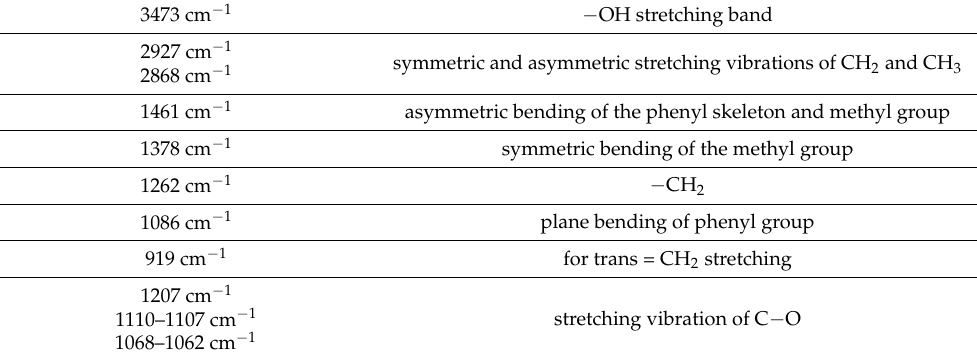
Table 3. ATR-FTIR bands assignment of alpha-tocopherol (E307)